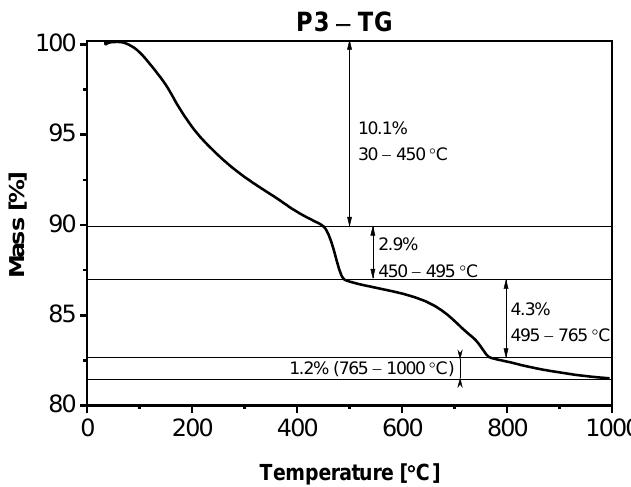
Figure 7. TGA of sample P3 after 28 days of curing.